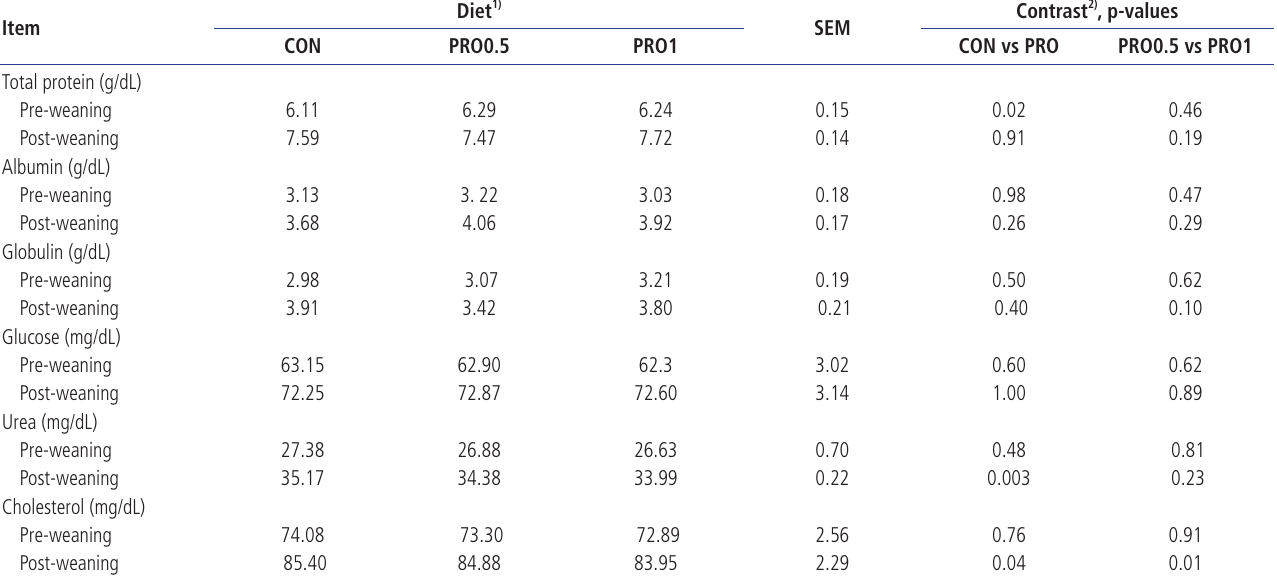
Table 5. Effects of probiotic (PRO) supplementation on pre- and post-weaning blood metabolites Item